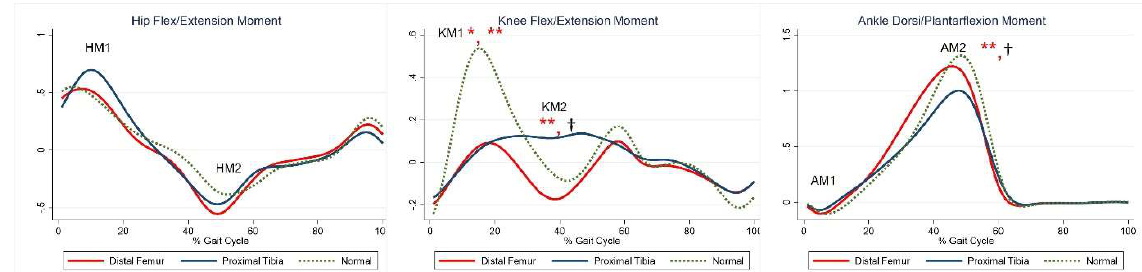
Figure 3. Moment for each group. The red lines represent mean values for the distal femur group. The blue lines represent mean values for the proximal tibia group. The dashed lines represent the healthy subjects. * Statistically significant for the comparison between distal femur group and healthy subjects. ** Statistically significant for the comparison between proximal tibia group and healthy subjects. † Statistically significant for the comparison between distal femur group and proximal tibia group.